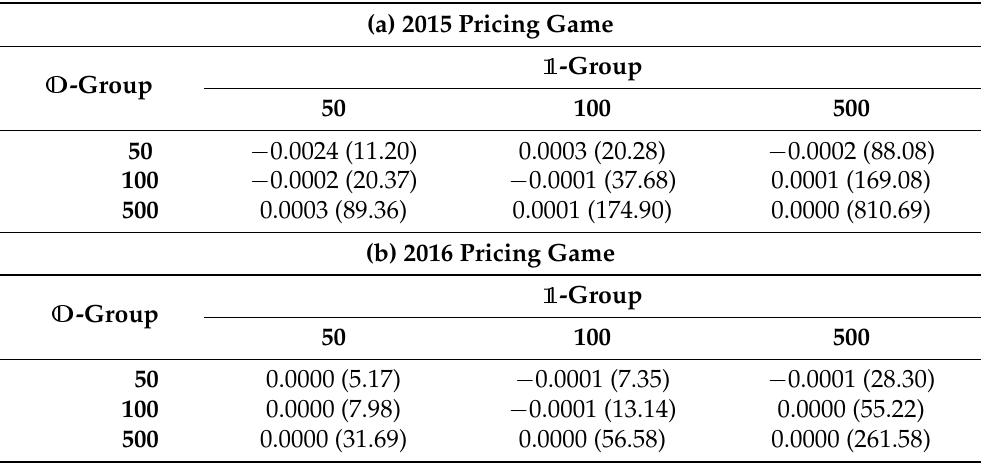
Table A3. Bias and run time (s), the latter between brackets, for the approximation ˆC on the 2015 and 2016 pricing game dataset. This is given for the fine grid approach and for several different numbers of clusters for the O - and 1